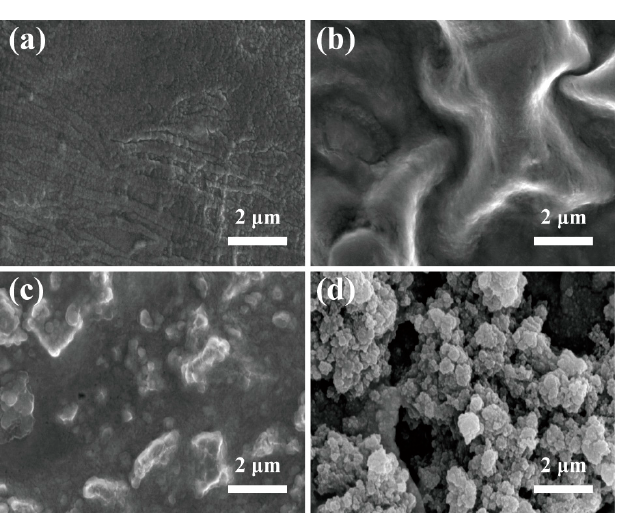
Figure 1. SEM images of lithium metal foils: ( a ) original; ( b ) RT-1D battery; ( c ) RT-7D battery; ( d ) 55 °C-7D battery.